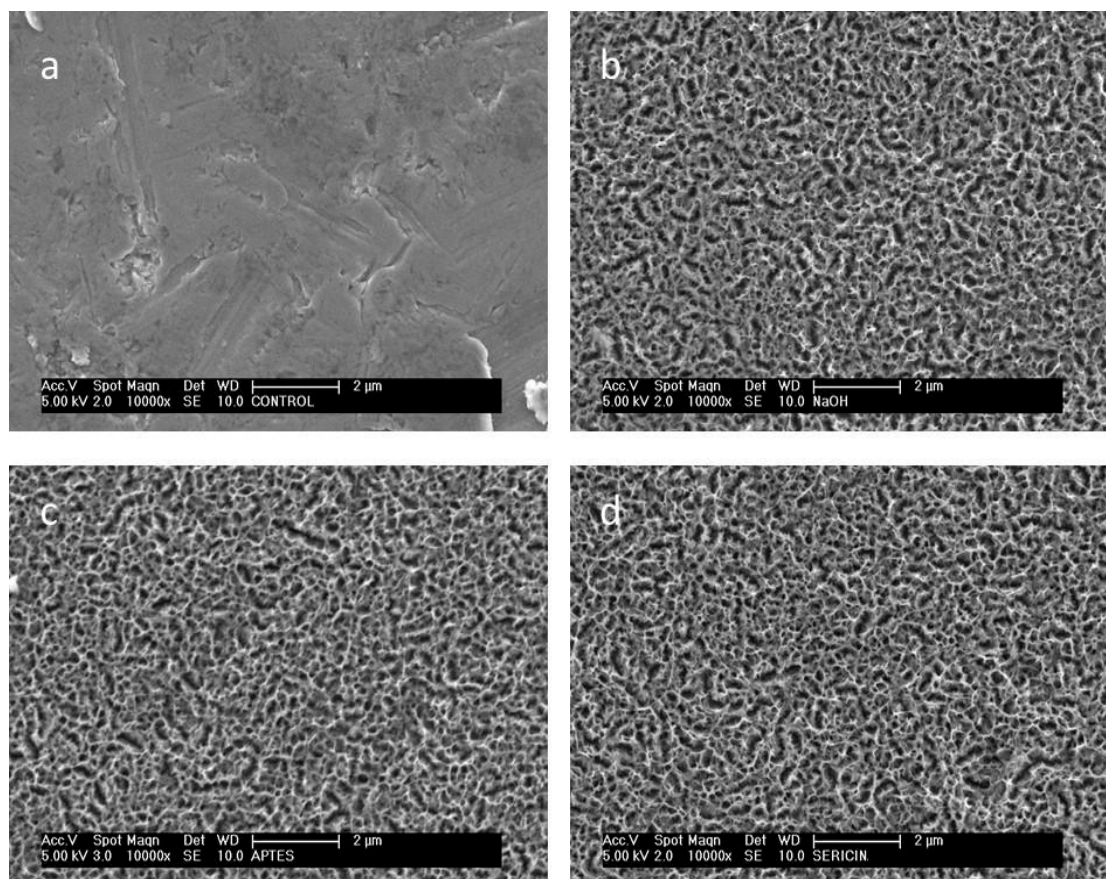
Figure 2. Micromorphology of the disk surface at different production step: ( a ) untreated control, ( b ) after etching (NaOH), ( c ) after etching and silanization (NaOH + VapAPTES), ( d ) after etching, silanization and sericin bioconjugation with glutaraldehyde (NaOH + VapAPTES + GLU). Images ( c ) and ( d ) are representative also for the micromorphology of disks subjected to the alternative silanization (SolAPTES) and bioconjugation (EDC/NHS) processes respectively. Scanning electron microscopy, secondary electrons detector signal, original magnification 10000×.